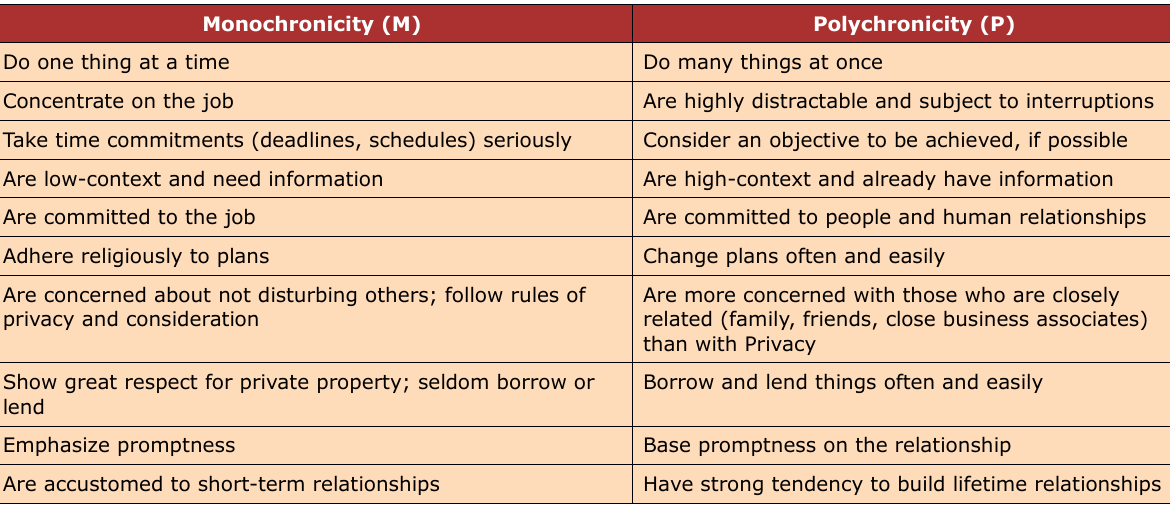
Table 4. Contrast characteristics between Monochronicity (M) and Polychronicity